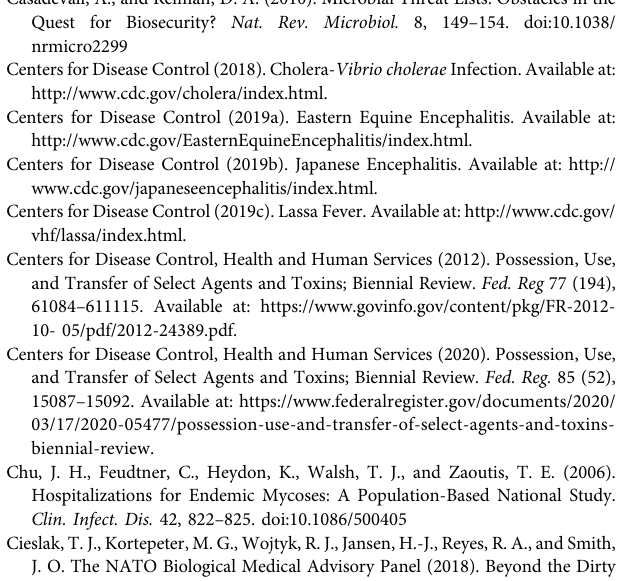
Supplementary Table S1 | Criteria scoring de fi